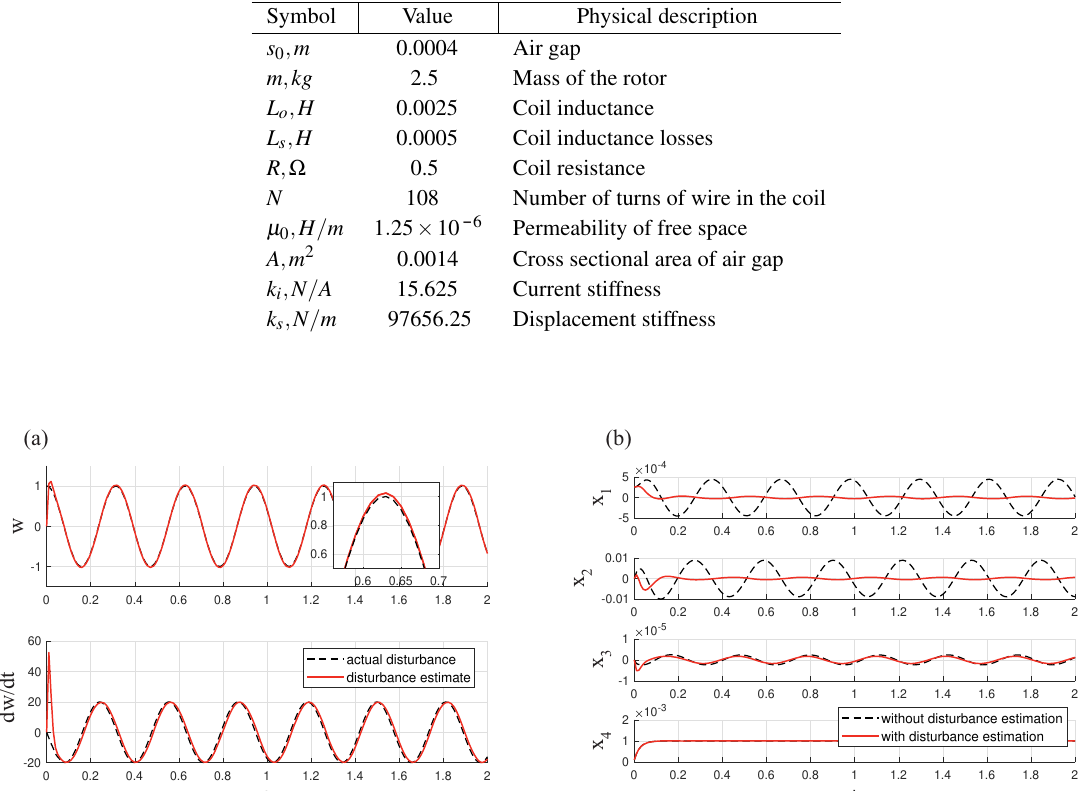
Figure 2. (a) Disturbance w , its time-derivative ˙ w and their estimate; (b) The state trajectories compared to the case when there is no disturbance estimation added to the control design.